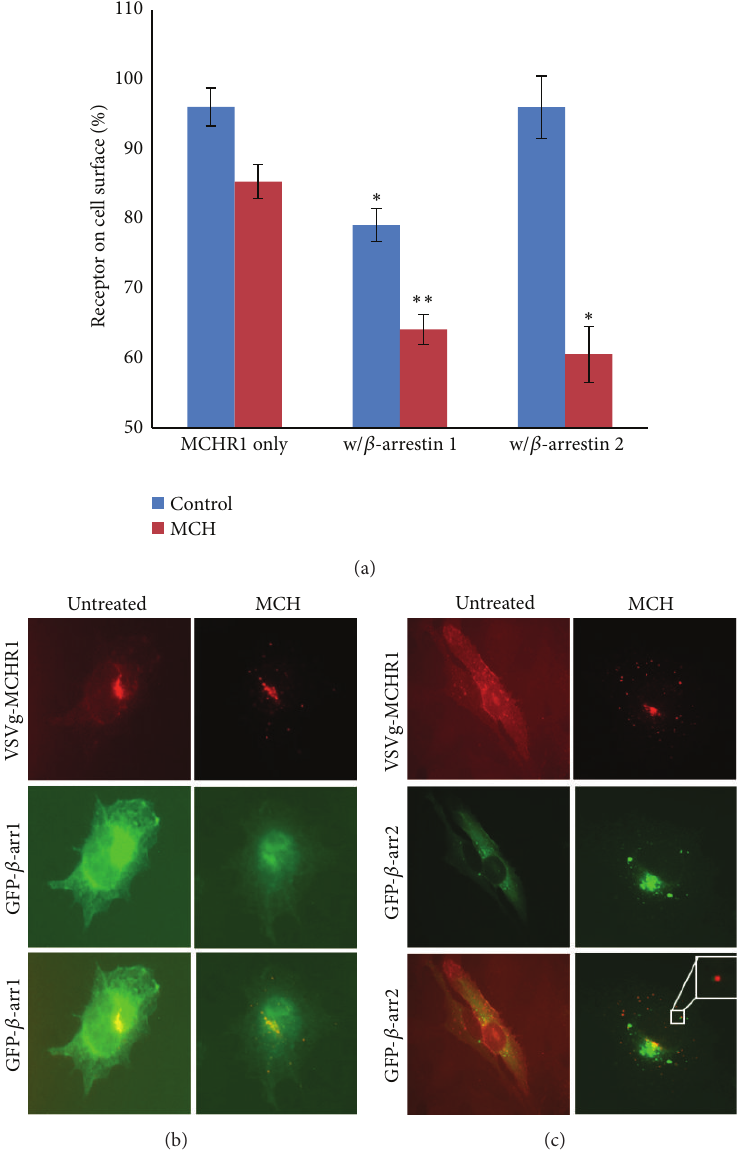
Figure 4: Overexpression of 𝛽 -arrestins differentially influences MCHR1 internalization. BHK-570 cells were transfected with VSVg-MCHR1 and either 𝛽 arrestin-1 or 𝛽 arrestin-2. (a) Cells were treated with 1 𝜇 M MCH or vehicle for 30 min and internalization was measured utilizing a cell-based ELISA. Data from Figure 3 was replotted. Ave ± SEM plotted. ∗∗ 𝑃 < 0.005 , ∗ 𝑃 < 0.01 . VSVg-MCHR1 and GFP 𝛽 -arrestin 1-expressing cells (b) and VSVg-MCHR1 and GFP 𝛽 -arrestin 2-expressing cells (c) were treated with 1 𝜇 M MCH or vehicle for 30min, then fixed, and immunostained with anti-VSVg antibody. Fluorescence microscopy was performed and overlay images